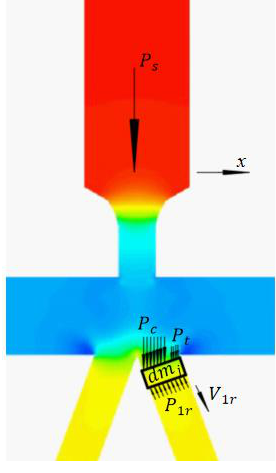
Figure 6. Stress analysis diagram.